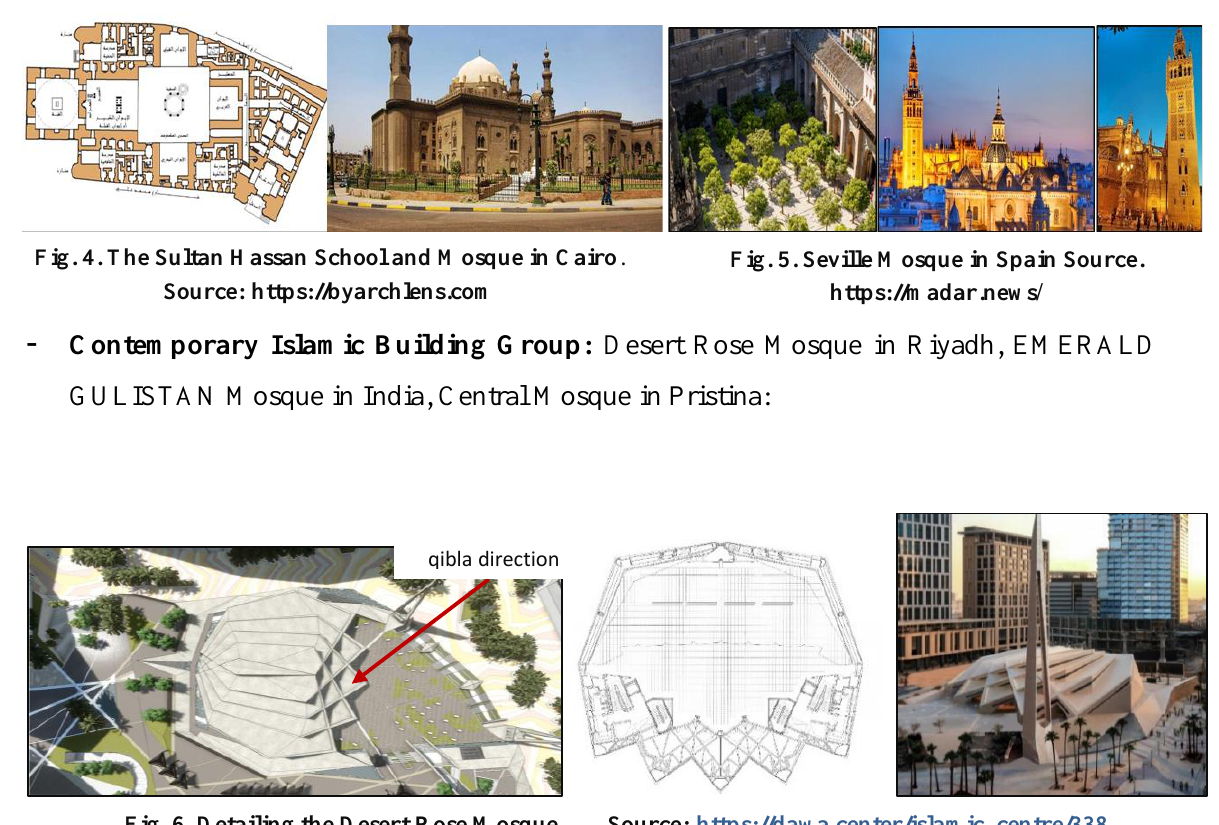
Fig. 6. Detailing the Desert Rose Mosque.